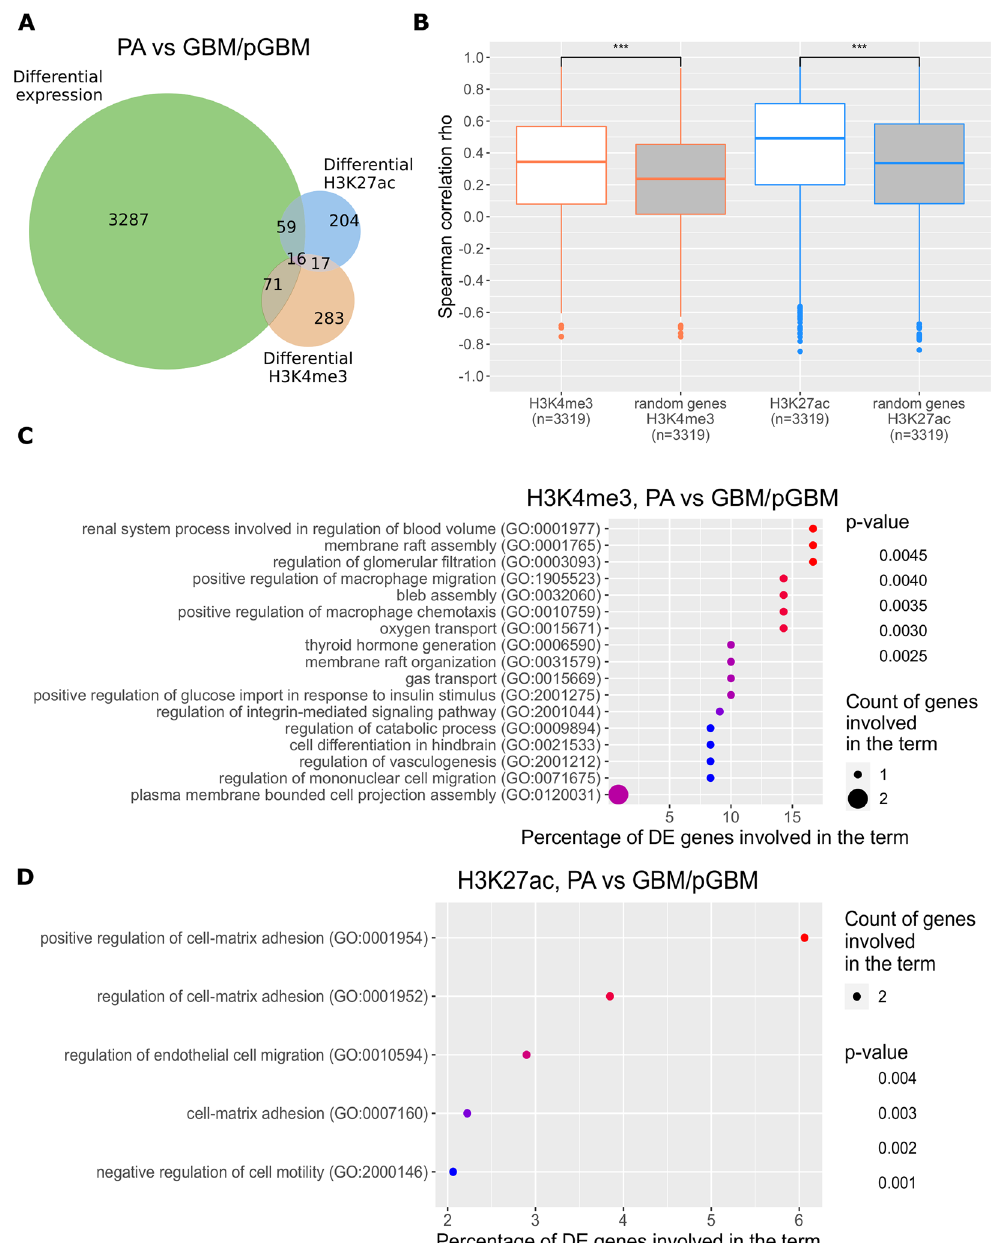
Figure 1. Identification of genes differentially expressed in benign and malignant gliomas (PA vs GBM/ pGBM). ( A ) Intersection of differentially expressed genes (DEGs) with genes carrying differential epigenetic modifications (DEMs) for the PA vs GBM/pGBM comparison. ( B ) Correlation of H3K4me3 (orange boxes) and H3K27ac (blue boxes) coverages at the promoters of DEGs (PA vs GBM/pGBM) with their expression. Boxes filled with white show values for DEGs, while in grey for the randomly chosen active genes. ( C ) Enrichment of Biological Process GO terms for DEGs in PA vs GBM/pGBM comparison having high correlation of expression levels with H3K4me3 (Spearman rho > 0.7), and being prognostic for glioma patients’ survival (log-rank test p < 0.001). ( D ) As in ( C ) for